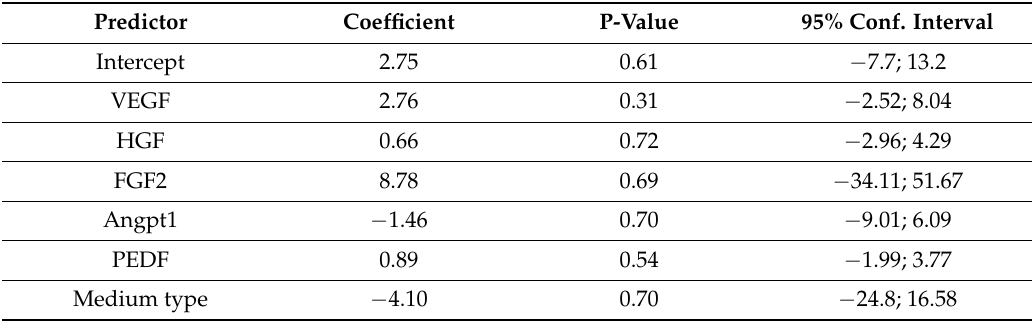
Table 3. Prediction model for MSC-CM sample potency to stimulate human endothelial cell migration; n = 20 for train group, n = 11 for validation group.